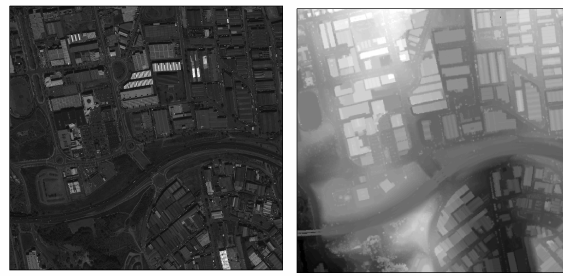
Figure 2: Left: Nadir Image of the AOI Right: LiDAR DSM